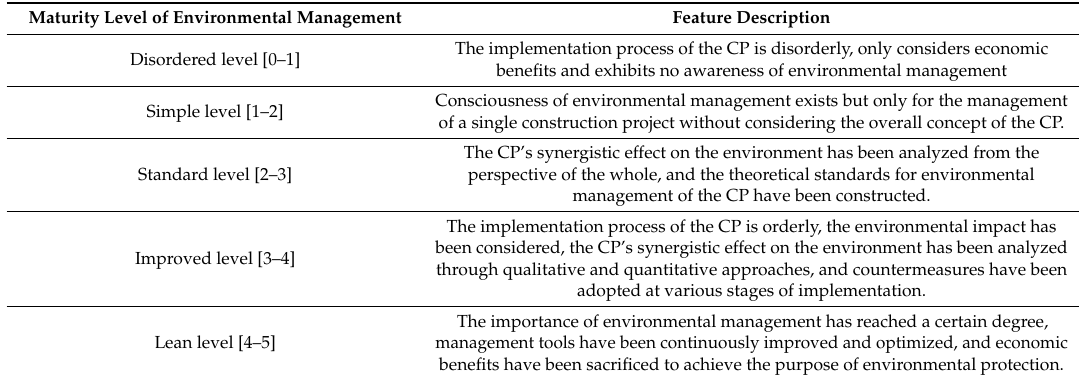
Table 5. Feature description of the environmental management maturity of